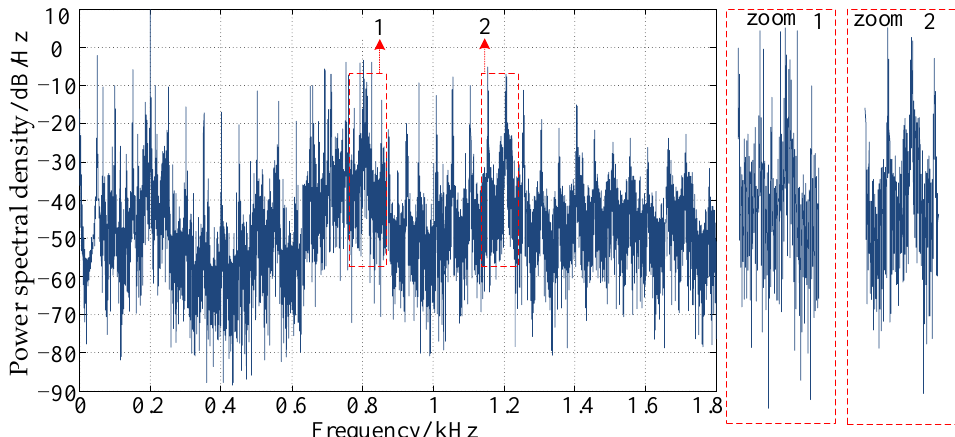
distortion of the stator current, which can not only reduce the torque ripple, but also weaken the vibration of the IM. Figure 26. The vibration measurement platform. Figure 26. The vibration measurement platform.